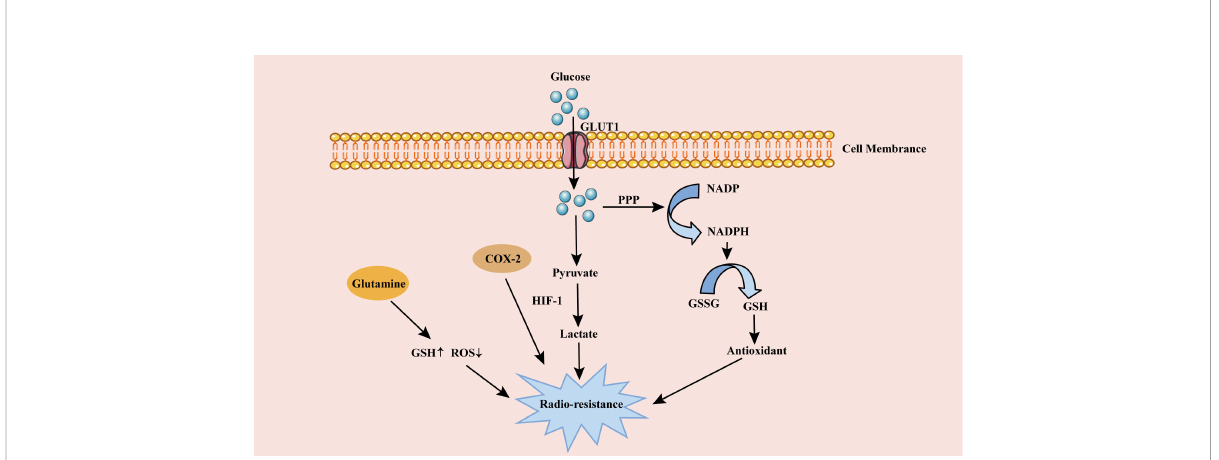
FIGURE 2 The role of metabolism on cervical cancer radioresistance. Glucose is transported into cells through GLUT1 for glycolysis and produces a large amount of lactic acid, enhancing cervical cancer radioresistance. Glucose in cells also produces GSH through PPP pathway. The antioxidant GSH weakens DSB after RT, resulting in radioresistance of cervical cancer cells. High expression of COX-2 in lipid metabolism and Glutamine in amino acid metabolism also contribute to cervical cancer radioresistance. GLUT1, glucose transporter 1; PPP, pentose phosphate pathway; ROS, reactive oxygen species; HIF-1, hypoxia-inducible factor 1; GSSG, oxidized glutathione; GSH, glutathione; RT,